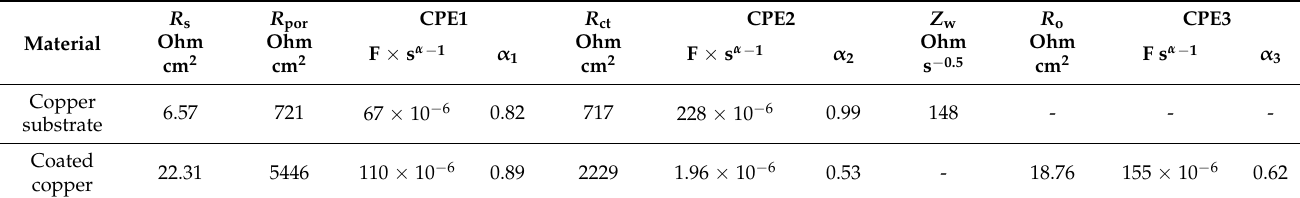
Table 2. Best fitting parameters obtained using the proposed equivalent circuits, delineating the corrosion behavior of uncoated and silver silver-coated